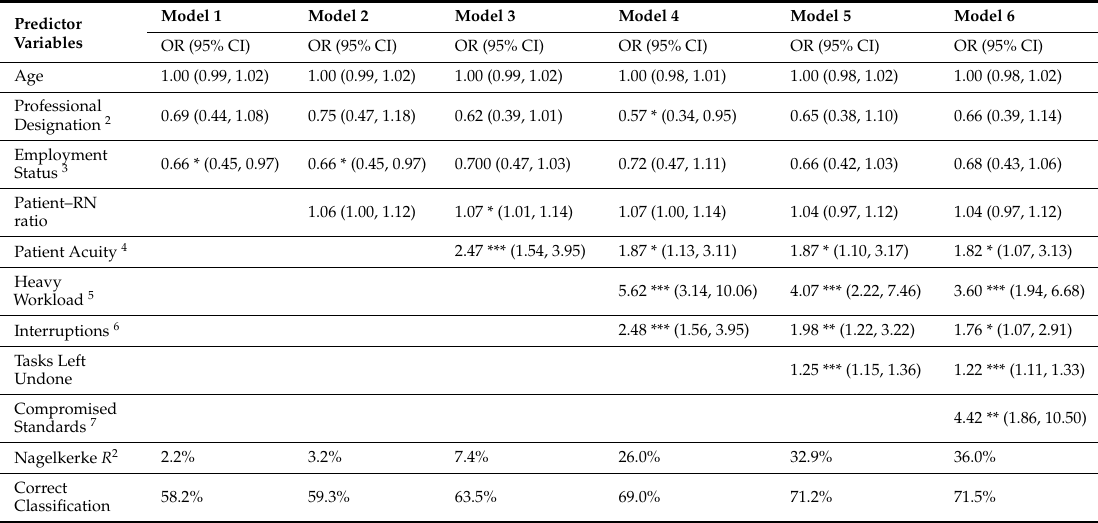
Table 5. Results of hierarchical logistic regression analyses for emotional exhaustion 1 among nursing